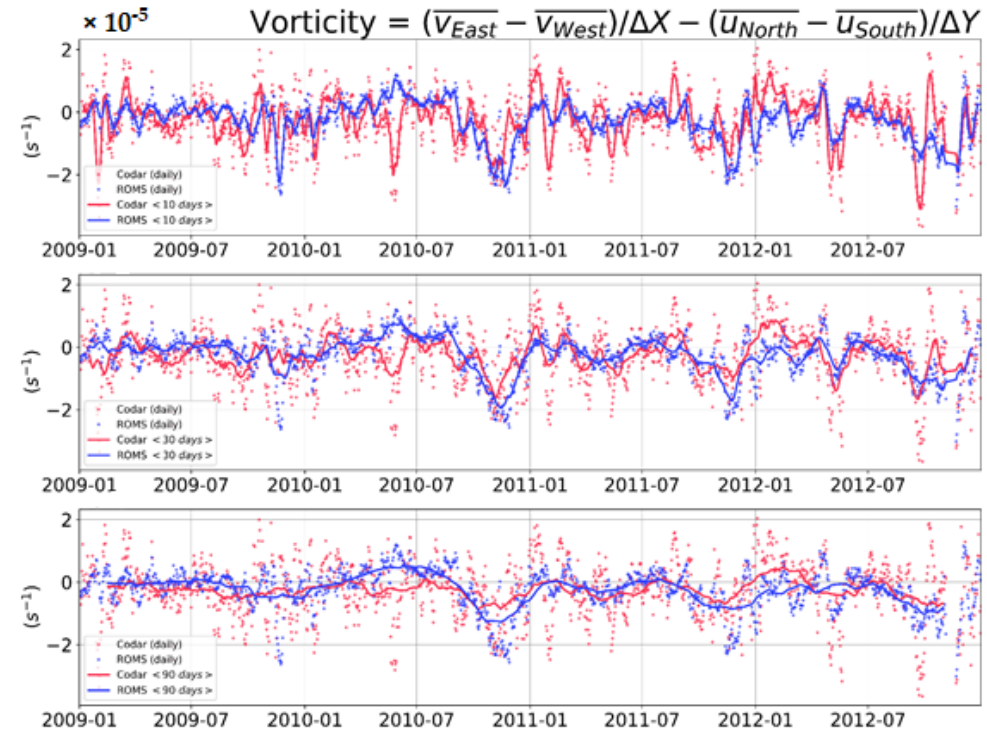
Figure 10. Vorticity index, smoothed with a running-average window of 10, 30, and 90 days (top, middle , and bottom , respectively). Primary daily values are indicated with the dots in background. Red: HFR observations; blue: ROMS model.